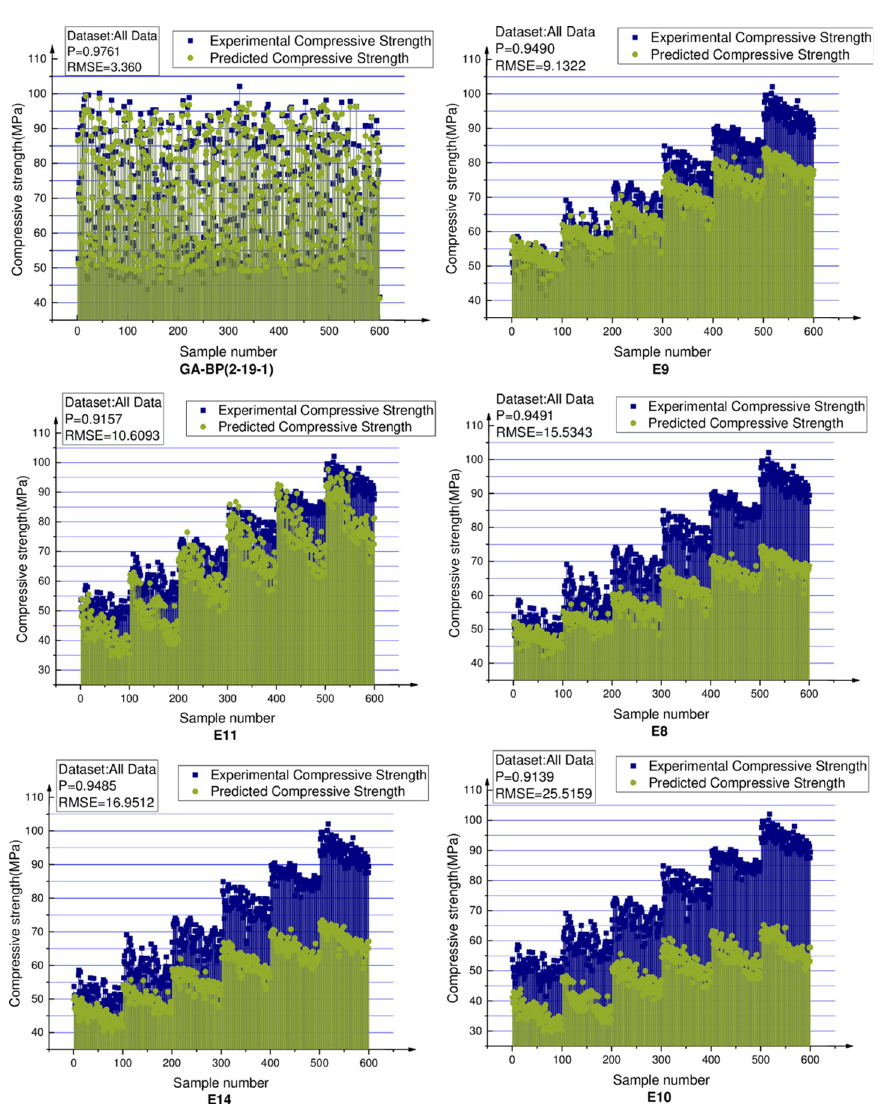
Fig 25. Comparison of the first six concrete compressive strength prediction